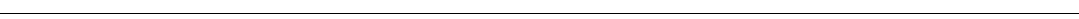
Fig. 4 Functional characterization of rs146662075 association signal. a Signal plot for X chromosome region surrounding rs146662075. Each point represents a variant, with its p -value (on a − log10 scale, y axis) derived from the meta-analysis results from association testing in males. The x axis represents the genomic position (hg19). Below, representation of H3K27ac and RNA-seq in a subset of cell types is shown. The association between RNA- seq signals and H3K27ac marks suggests that AGTR2 is the most likely regulated gene by the enhancer that harbors rs146662075. b The presence of the common allelic variant rs146662075-C reduces enhancer activity in luciferase assays performed in a mouse myoblast cell line. c Electrophoretic mobility shift assay in C2C12 myoblast cell lines, C2C12-differentiated myotubes, and human fetal myoblasts showed allele-speci fi c binding of a ubiquitous nuclear complex. The arrows indicate the allele-speci fi c binding event. Competition was carried out using 50- and 100-fold excess of the corresponding